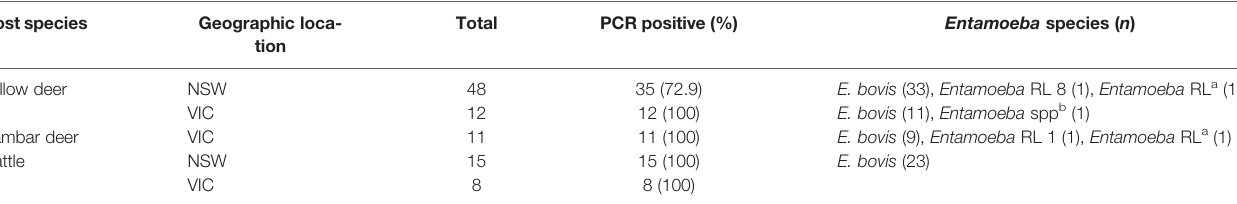
TABLE 1 | Entamoeba species and RLs identi fi ed in deer and cattle faecal samples collected across south-eastern Australia. Host